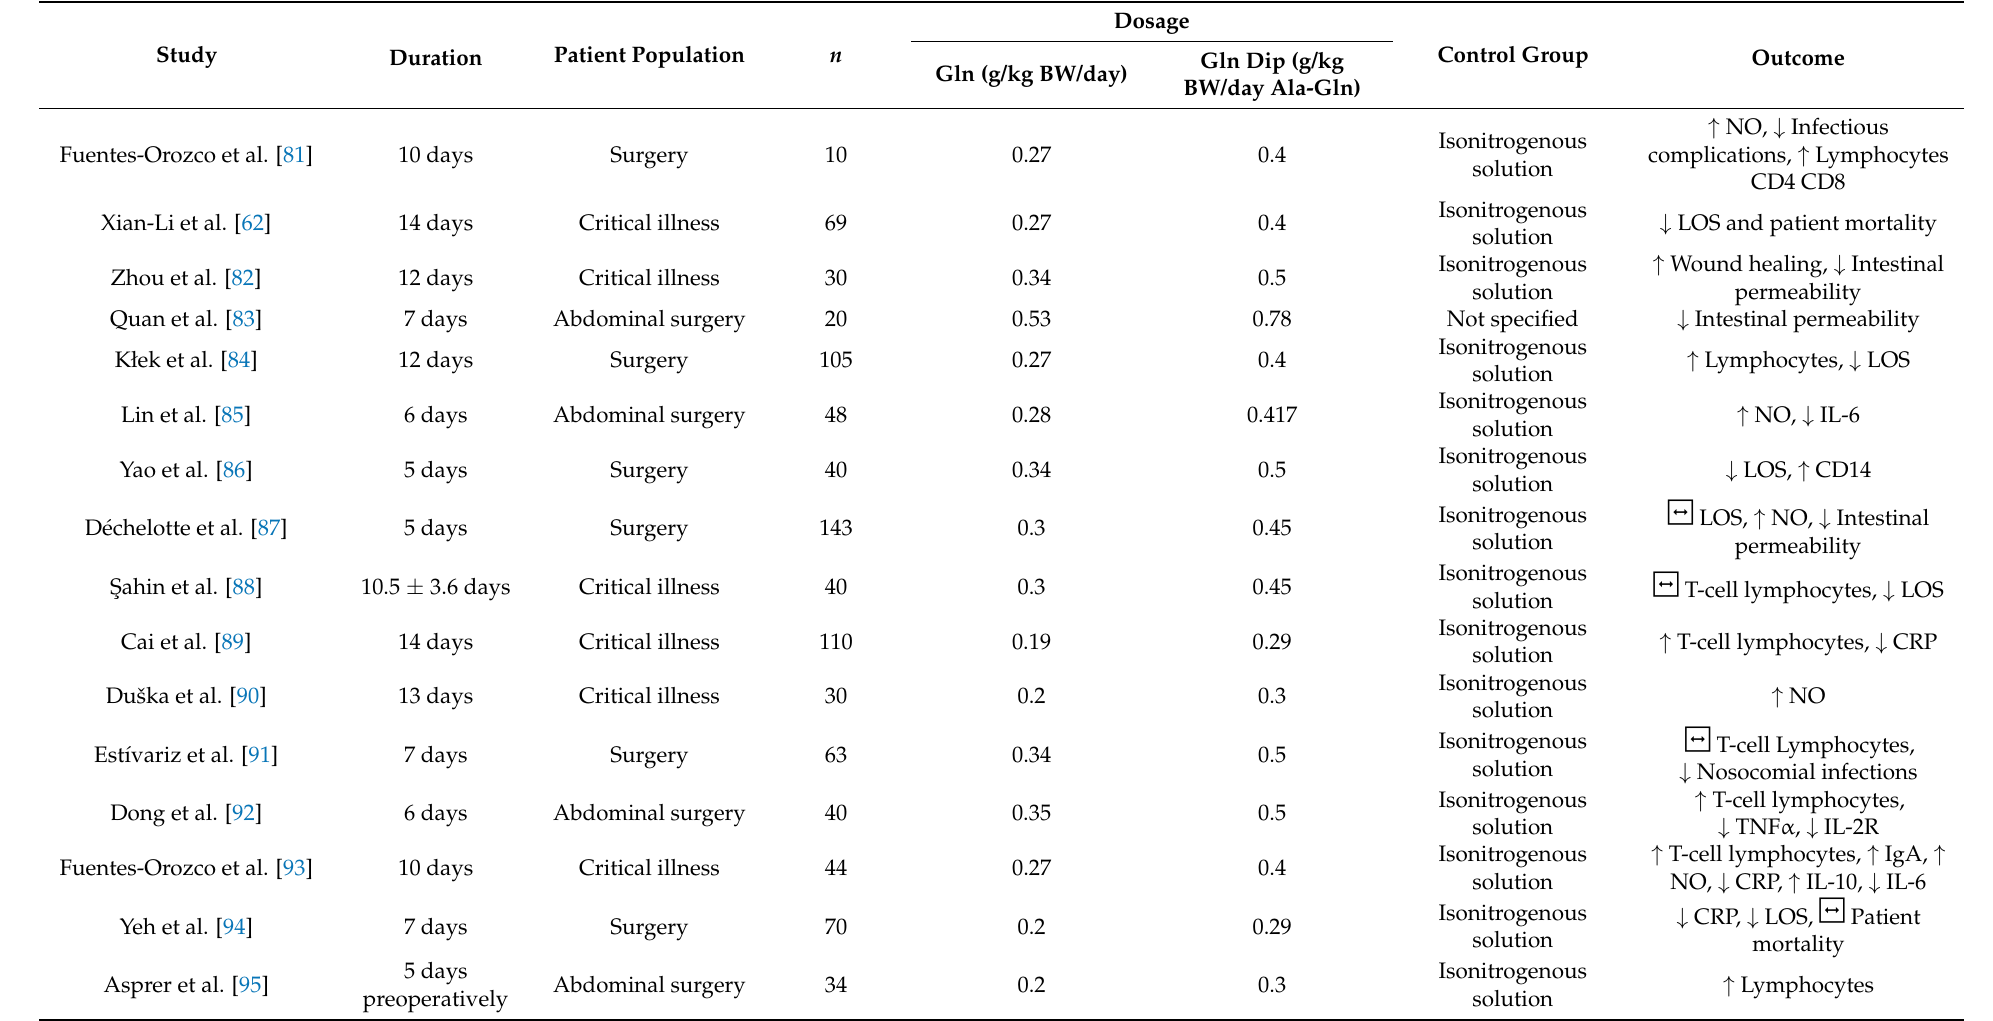
Table 2. Studies evaluating the effect of arginine supplementation on wound healing and reported outcomes.